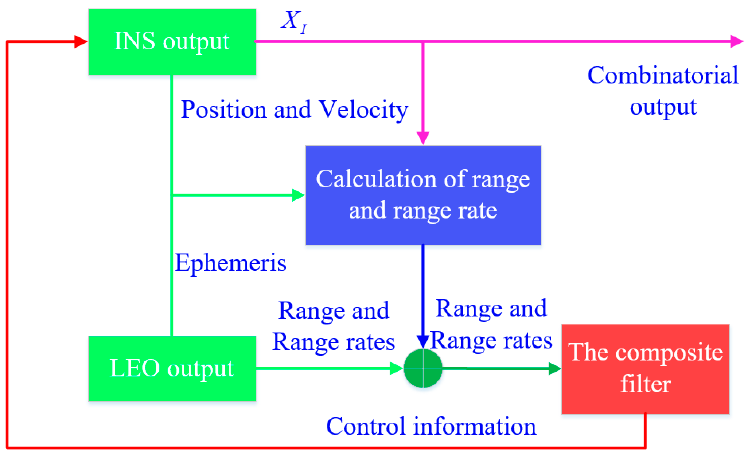
Figure 4. Flow chart of the INS+LEO 1 satellite compact integrated navigation algorithm without an altimeter.